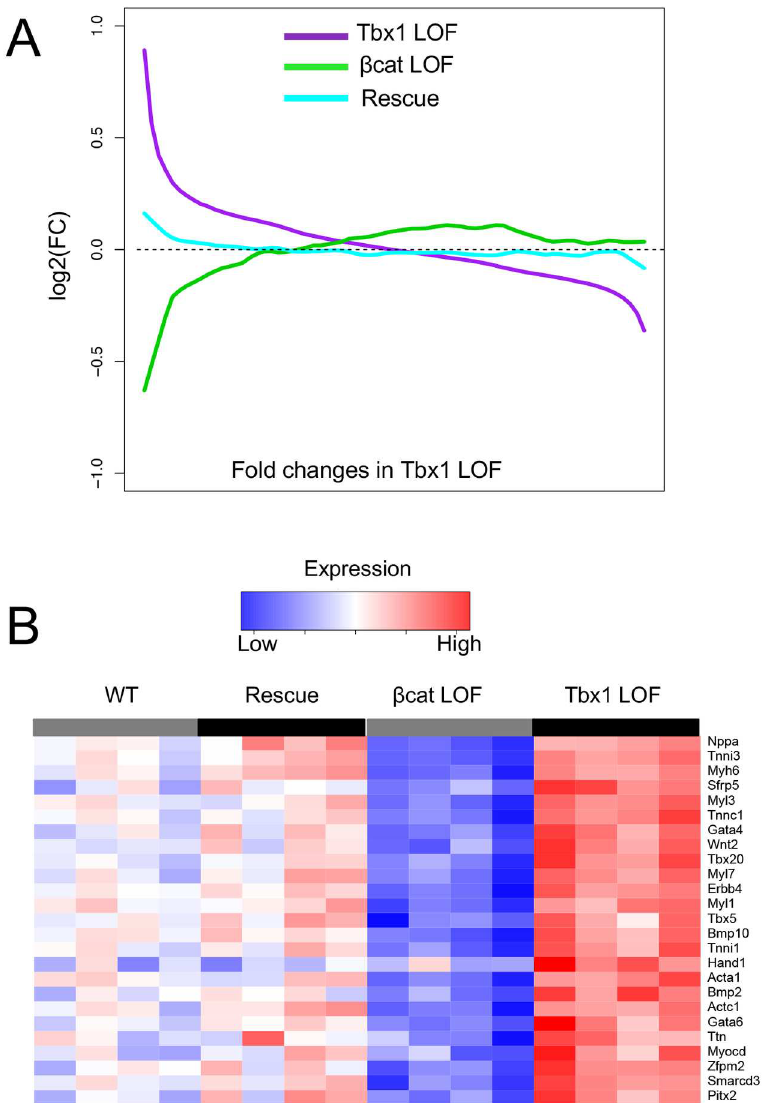
Fig 6. Gene expression of cardiac muscle differentiation genes are normalized in rescuedembryos. (A) Comparisonof globalexpressionchanges.Differentially expressedgenes (p < 0.05; n = 3,636) in either Tbx1 LOF or β -cateninLOF were sorted by their FC between Tbx1 LOF and controls (x-axis). The sorted geneswere grouped(50 genesper group) and then the averageexpressionchangesfor each group in the Tbx1 LOF , β -cateninLOF or rescue embryos (vs controls) were plotted in the y-axis. (B) Heatmap showing the expressionof selectedkey genesincreasedin expressionin Tbx1 LOF embryos but decreased in expressionin β -cateninLOF